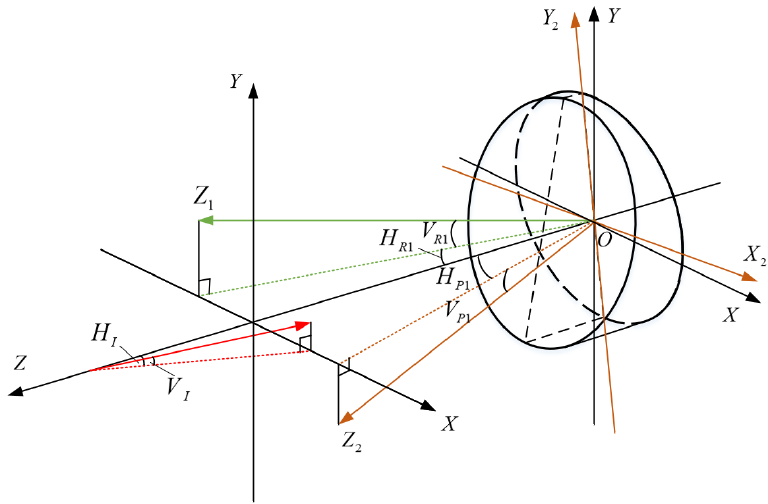
Figure 4. Diagram illustrating the assembly errors of the prisms and their